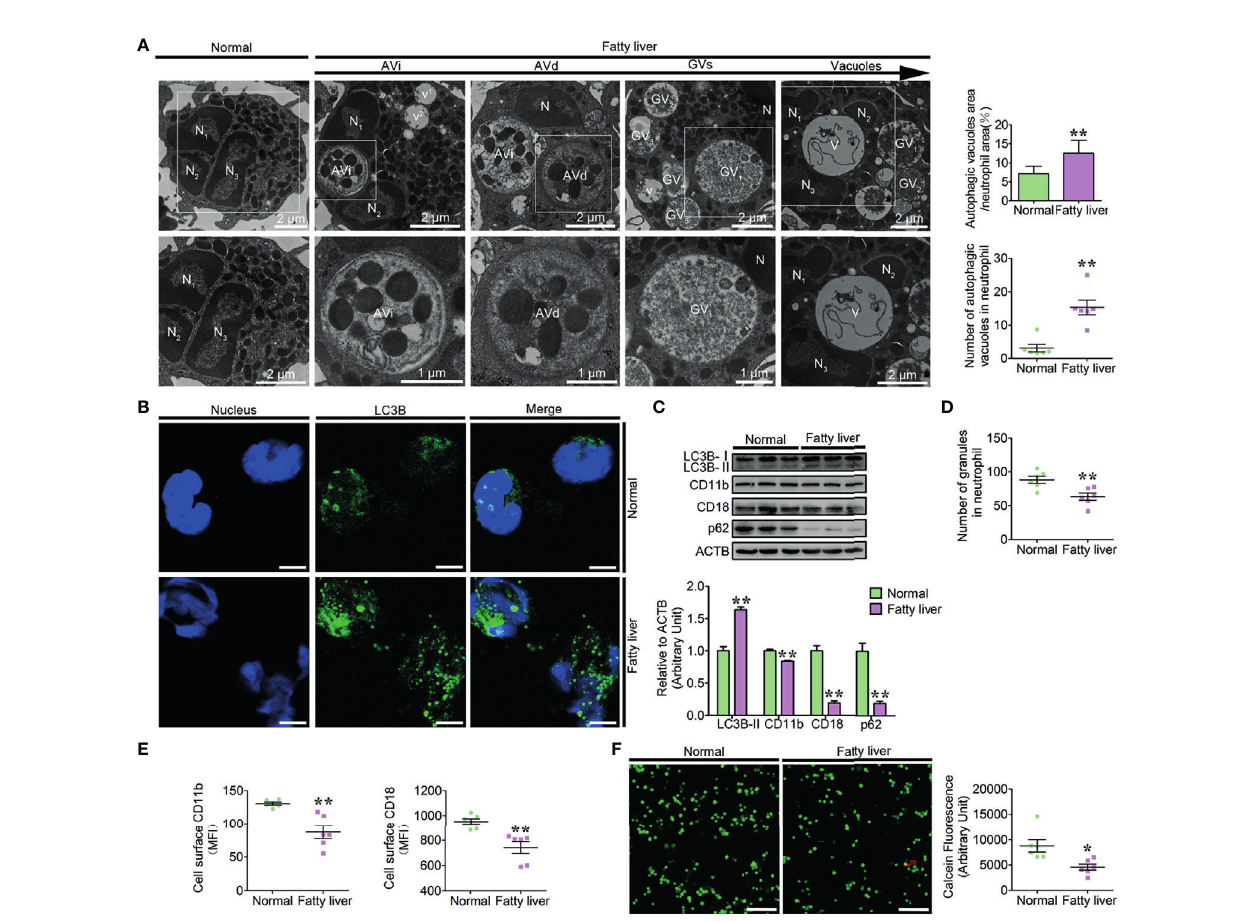
FIGURE 1 | Increased autophagy, vacuolation, and adhesion de fi ciency existed in fatty liver dairy cow neutrophils. (A) Representative transmission electron micrographs of normal and fatty liver neutrophils. White arrows indicate autophagic vacuoles (AVi, AVd, GVs, and vacuoles). N (N1, N2, and N3), nucleus. Scale bars as indicated. The area ratio of autophagic vacuoles to neutrophils and the number of autophagic vacuoles in neutrophils were determined ( n = 6). Data represent the mean ± s.e.m. (** p < 0.01 versus the control group; Signi fi cance calculated using t -test). (B) Autophagy levels were evaluated using confocal microscopy in neutrophils of normal and fatty liver cows. Neutrophils were stained with anti-LC3B antibody and nuclear DNA was stained with Hoechst 33258. Scale bar, 5 m m. (C) Immunoblot for LC3B, CD11b, CD18, and p62 in normal and fatty liver neutrophils. ACTB was used as a loading control ( n = 3). Data represent the mean ± s.e.m. (** p < 0.01 versus the control group; signi fi cance calculated using two-way ANOVA). (D) The number of granules in neutrophils ( n = 6) of normal and fatty liver cows. Data represent the mean ± s.e.m. (** p < 0.01 versus the control group; signi fi cance calculated using t -test). (E) Surface expression of CD11b and CD18 on normal and fatty liver cow neutrophils ( n = 6). Surface expression of CD11b and CD18 was assessed by fl ow cytometry analysis ( n = 6). MFI, mean fl uorescence intensity. Data represent the mean ± s.e.m. (* p < 0.05 and ** p < 0.01 versus the control group; signi fi cance calculated using t -test). (F) Representative fl uorescence micrograph images (left) and fl uorescence microplate analysis (right) of normal and fatty liver cow neutrophils ( n = 6). Scale bar, 400 m m. Data represent the mean ± s.e.m. (* p < 0.05 versus the control group; signi fi cance calculated using t